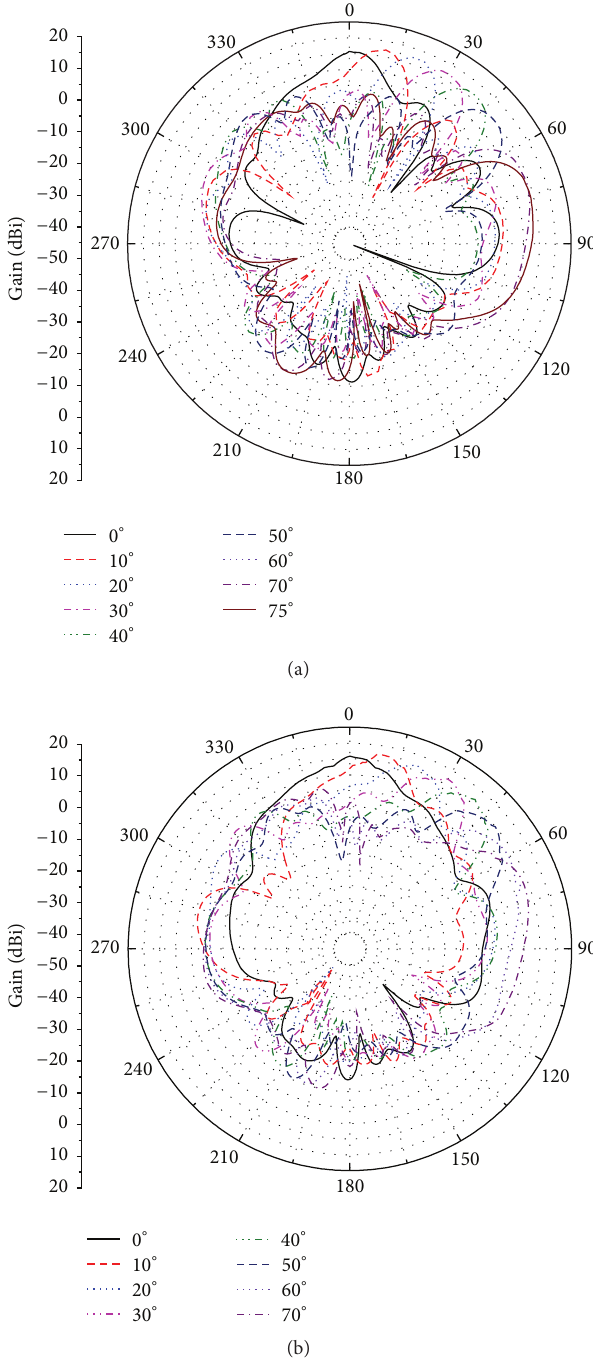
Figure 7: Scanning performance of the symmetric weighted thinned array. (a) Simulated results. (b) Measured results.